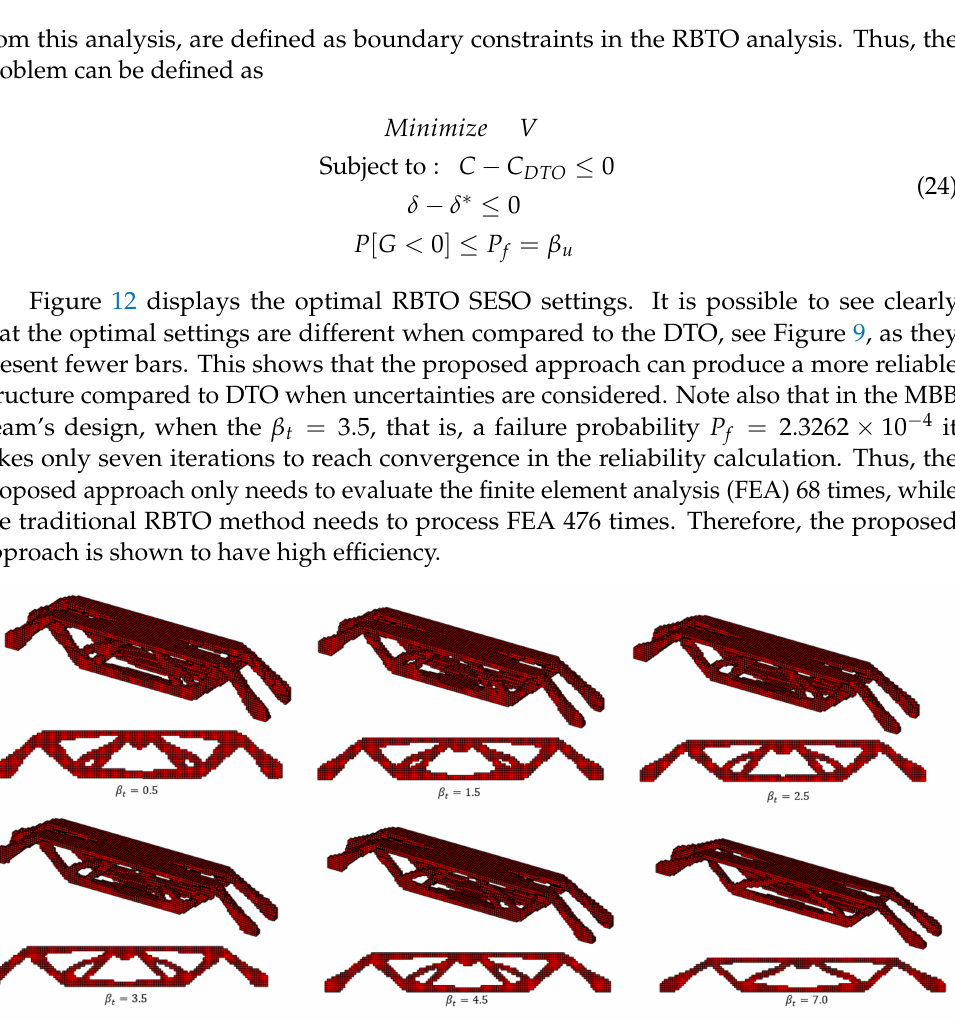
Figure 12. Optimal topologies for different reliability